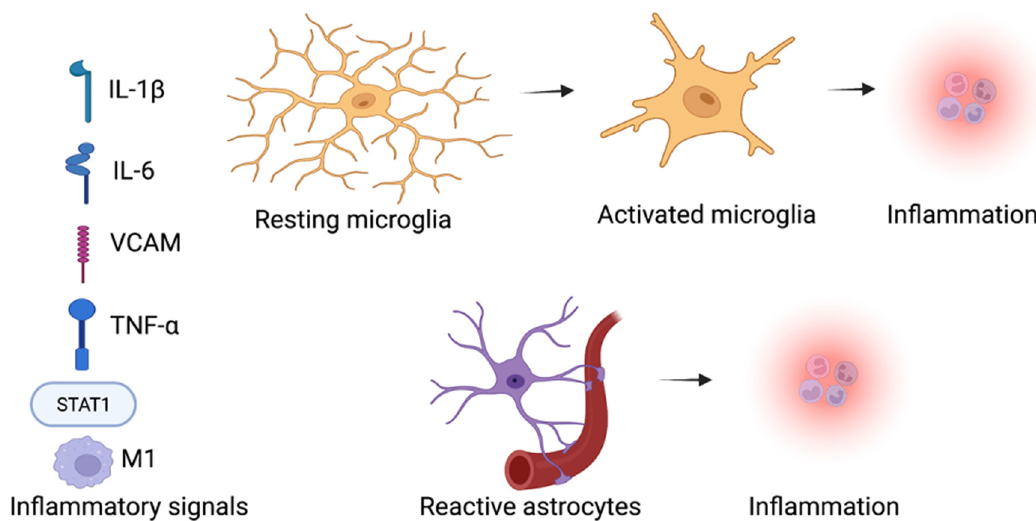
Figure 2. Inflammatory signals promote inflammation by activating the microglia and astrocytes within the brain in ASD. SGLT2 inhibitors influence on the inflammation and neuroinflammation, SGLT2 inhibitors decrease the inflammatory factors levels, such as the M1 macrophages, STAT1 inflammatory transcription factor, cytokine interleukin-1 β (IL-1 β ), tumor necrosis factor (TNF- α ), and vascular cell adhesion protein (VCAM) in neurodevelopmental diseases [43,44]. ( Created with BioRender.com).